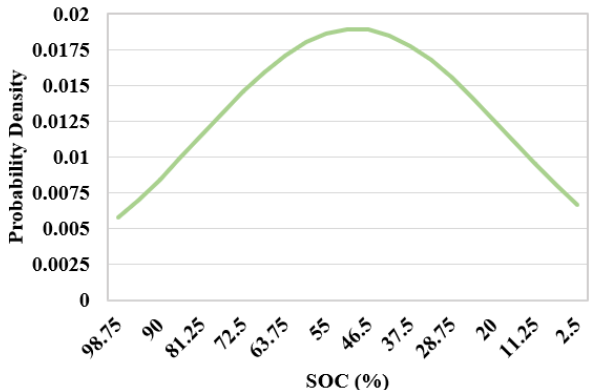
Fig.2. Probability Density Function of SOC of plugged-in PHEV